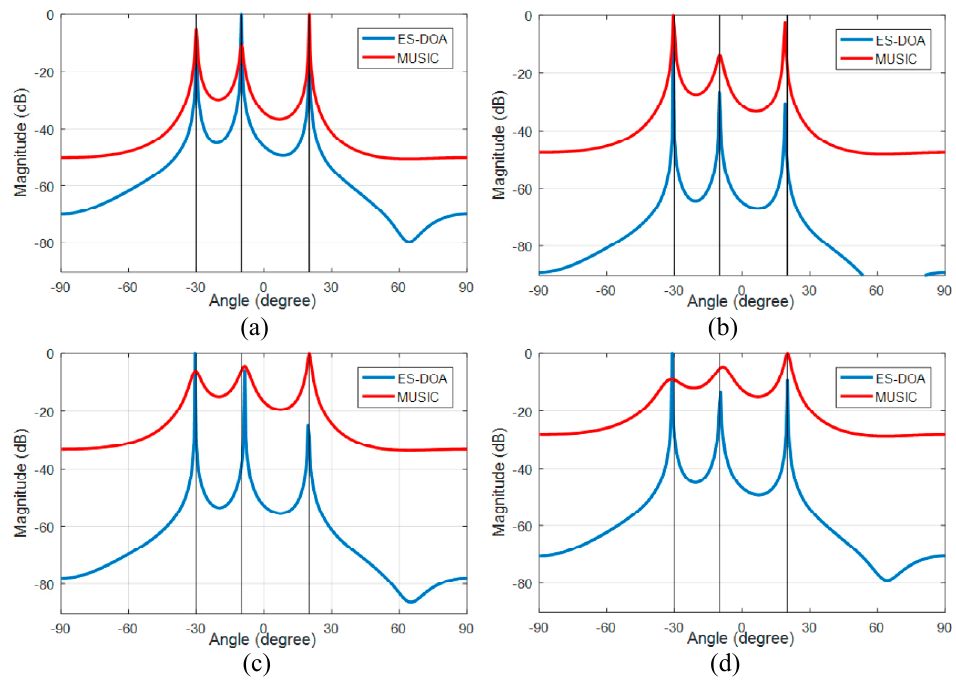
Figure 4. Azimuth spectrums of ES-DOA and MUSIC algorithms with 100 signal snapshots: ( a ) SNR = 20 dB; ( b ) SNR = 10 dB; ( c ) SNR = 5 dB; ( d ) SNR = 0 dB.